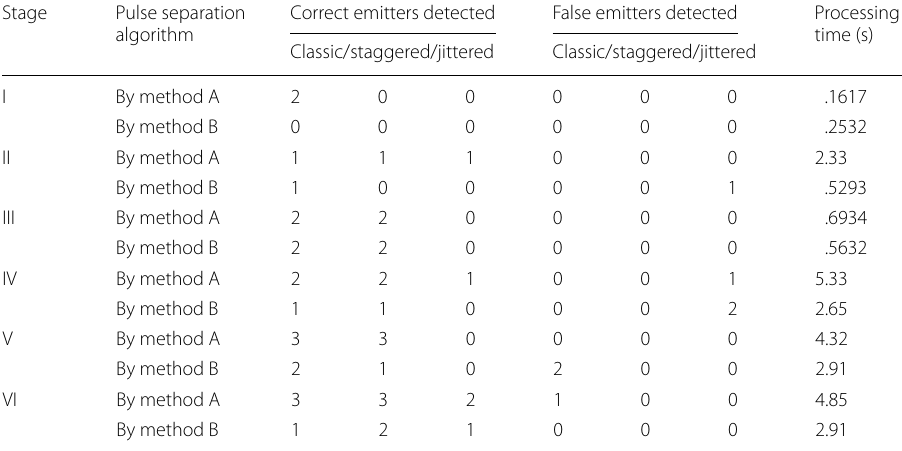
Table 2 The result of different states investigated in the separation of interleaved pulse trains by methods A and